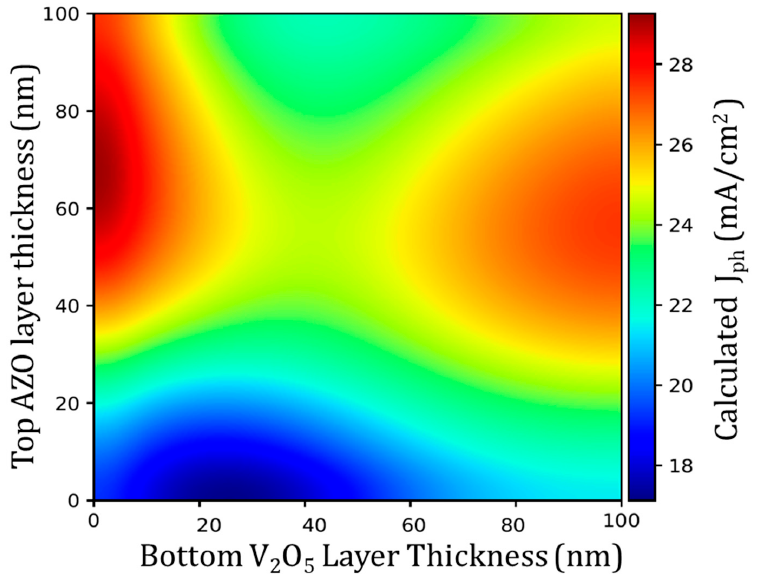
Figure 9. Mapping of the photogenerated current J ph under AM 1.5 irradiance as function of top AZO and bottom V 2 O 5 thicknesses. The Ag:Al intermediate layer thickness was fixed at 7.1 nm. AZO layer between 50 and 60 nm thickness and V 2 O 5 layer between 20 and 50 nm thickness shows better optical performance.